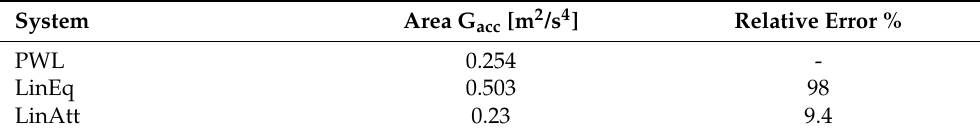
Table 9. Variances of acceleration for PWL, LinEq and LinAtt